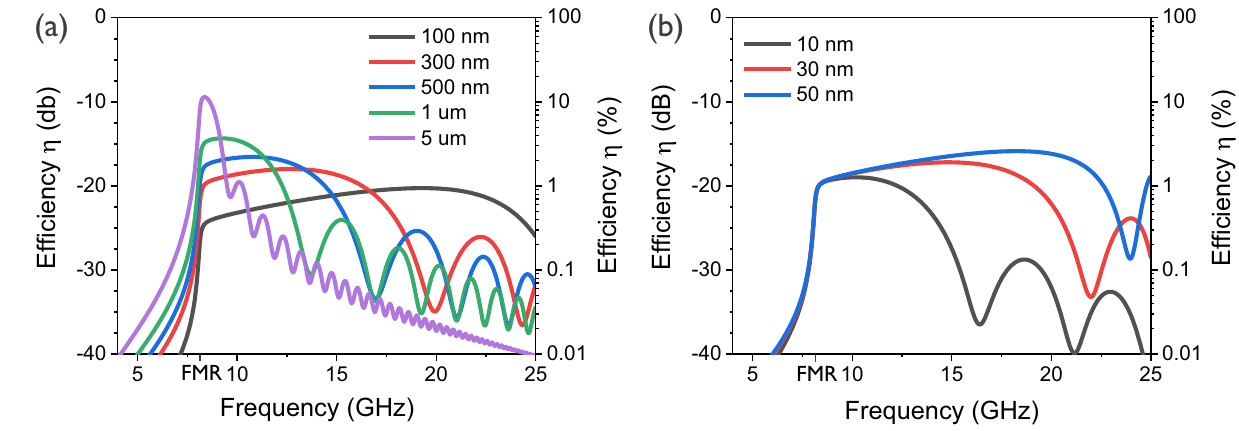
1 2 , maximum power transfer) in the